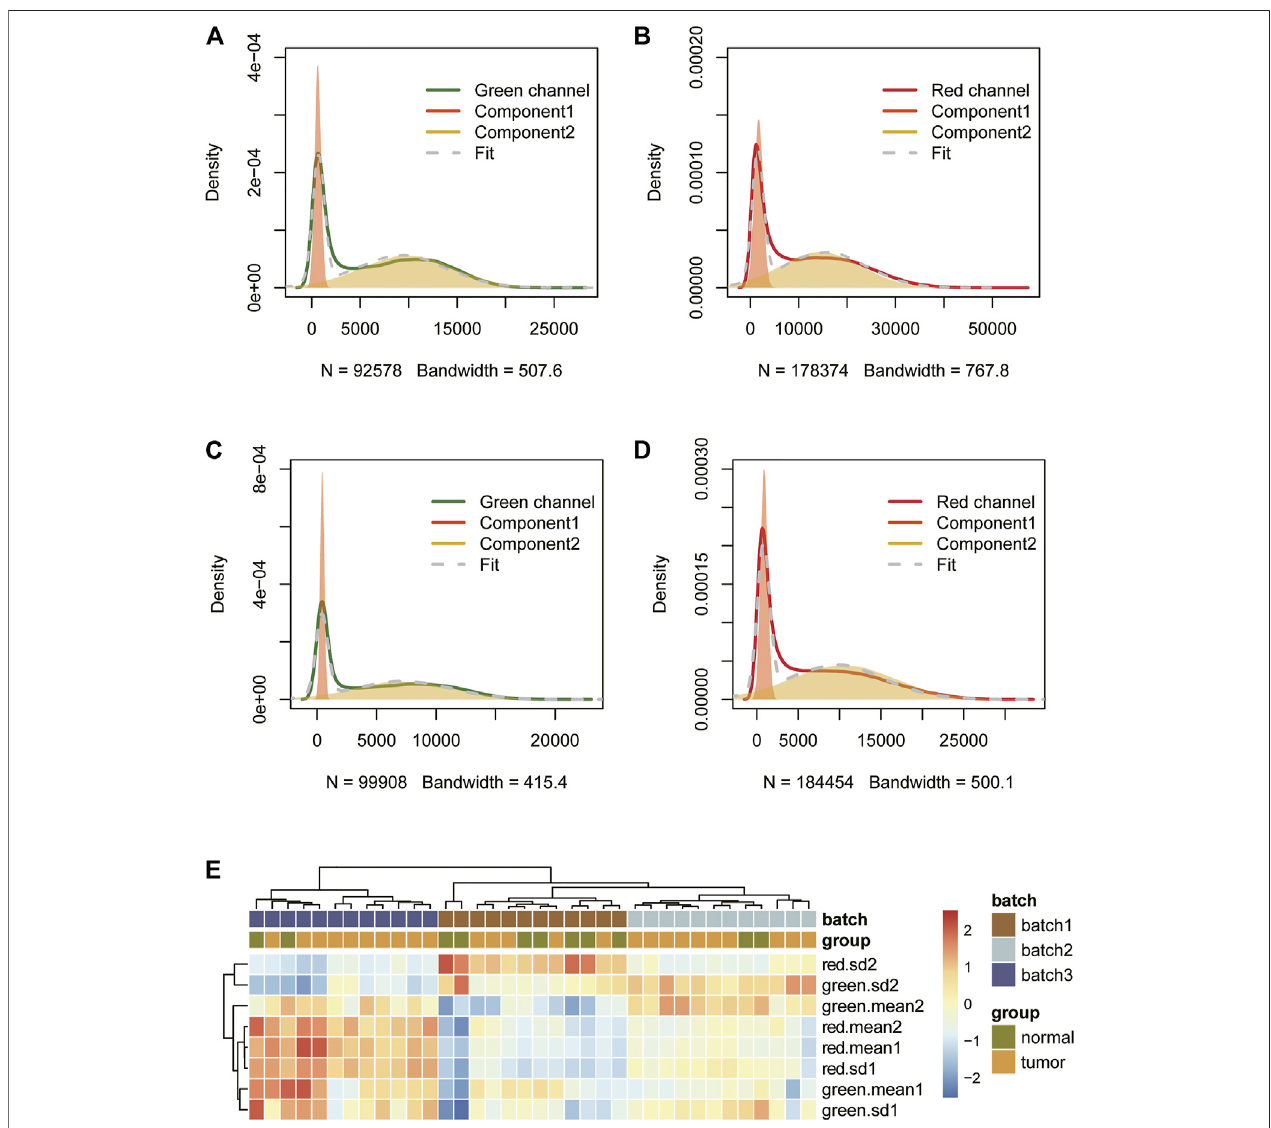
FIGURE 2 | The signal intensity distribution characteristics of In fi nium I probes (450 k data (A,B) , EPIC data (C,D) ) and clustering results of different batches of samples based on fi tting parameters of the Gaussian distributions (E) .